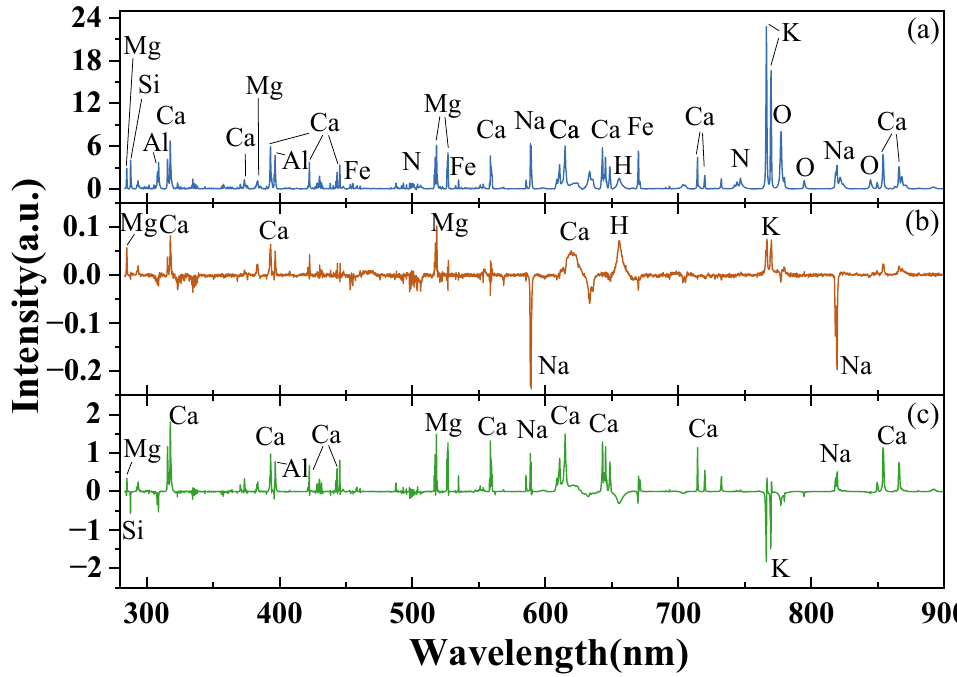
Figure 3. The LIBS spectra of soil samples. ( a ) The average spectra of all samples; ( b ) spectral difference of samples in topsoil and subsoil; ( c ) spectral difference of soil samples in the two study areas.